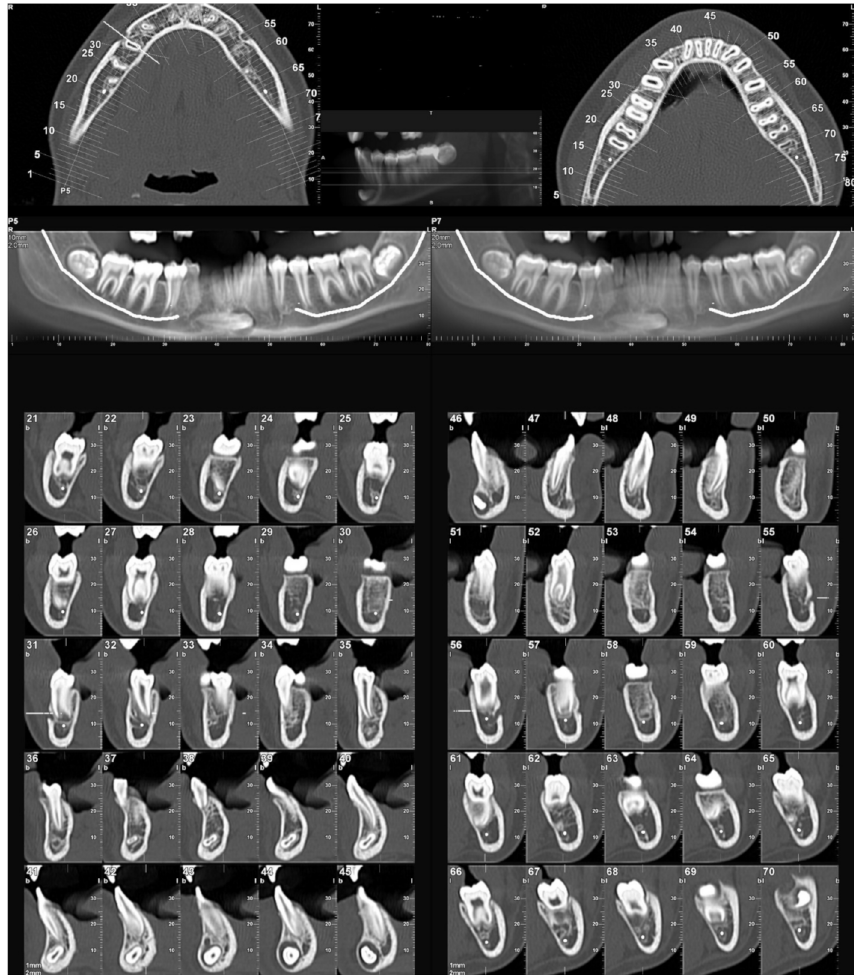
Figure 4. CBCT images with transmigrated canine type